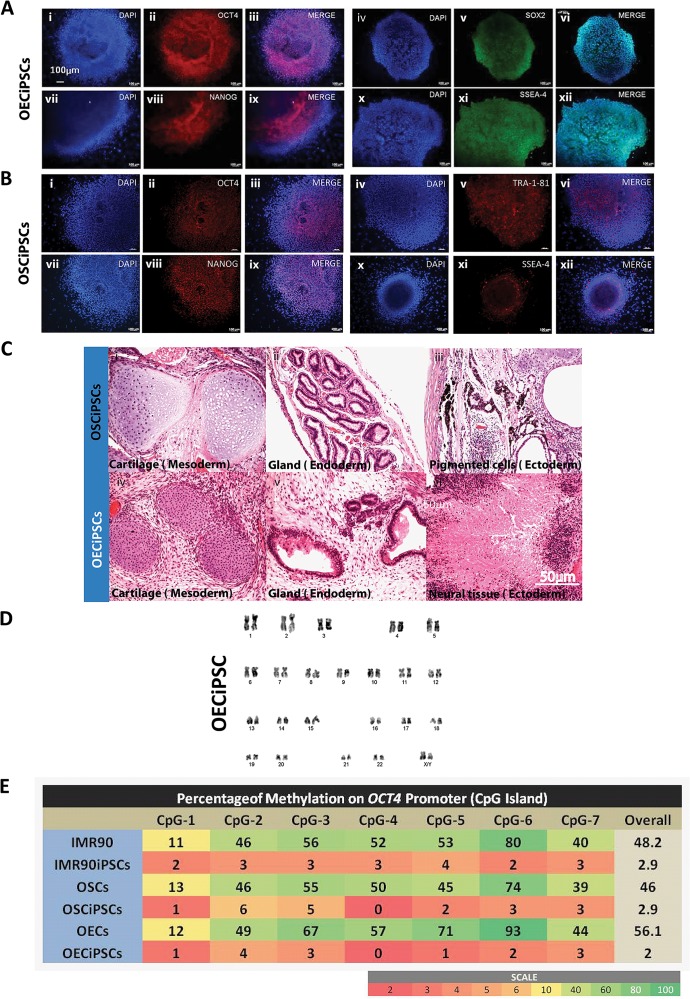
Characterization of pluripotency of OECiPSCs and OSCiPSCs.
(A) Immunostaining of pluripotency markers in OECiPSCs. (i-iii) OCT4, (iv-vi) SOX2, (vii-ix) NAGONG and (x-xii) SSEA-4. (B). Immunostaining of pluripotency markers in OSCiPSCs. (i-iii) OCT4, (iv-vi) TRA-1-81, (vii-ix) NANOG and (x-xii) SSEA-4 (C) Hematoxylin and eosin staining of teratoma tissues harvested from SCID mice after OECiPSCs and OSCiPSCs injection. Teratomas from both OECiPSCs and OSCiPSCs were constituted with mesodermal, endodermal and ectodermal germ-layer cell types, including cartilage, gland and pigmented cells/ or neural cells. (D) Karyotypes of representative iPSCs, OECiPSCs, was analyzed and normal chromosome structures were observed (OSCiPSCs chromosome structures similar to OECiPSC, data not shown).(E) Bisulfite conversion pyrosequencing data showing the percentages of methylation on OCT4 promoter of the primary cells (IMR90, OSCs and OECs) verus their corresponding iPSCs (IMR90iPSCs, OSCiPSCs and OECiPSCs).